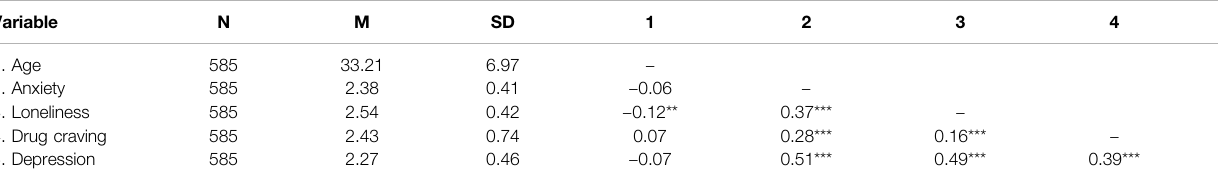
TABLE 2 | Descriptive statistics and correlations ( N (cid:1) 585). Variable